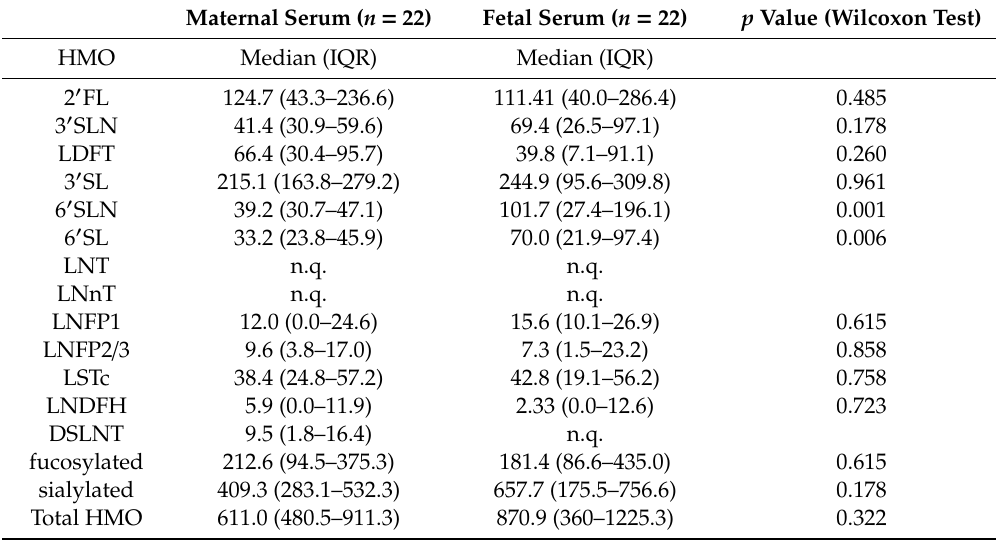
Table 2. HMO concentration in maternal serum at delivery and in cord blood (pmol / mL). Maternal Serum ( n = 22) Fetal Serum ( n = 22) p Value (Wilcoxon